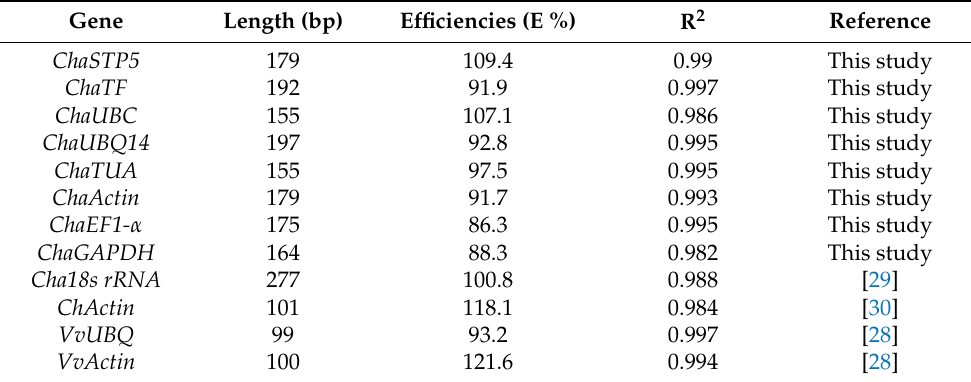
Table 2. Primers for candidate reference